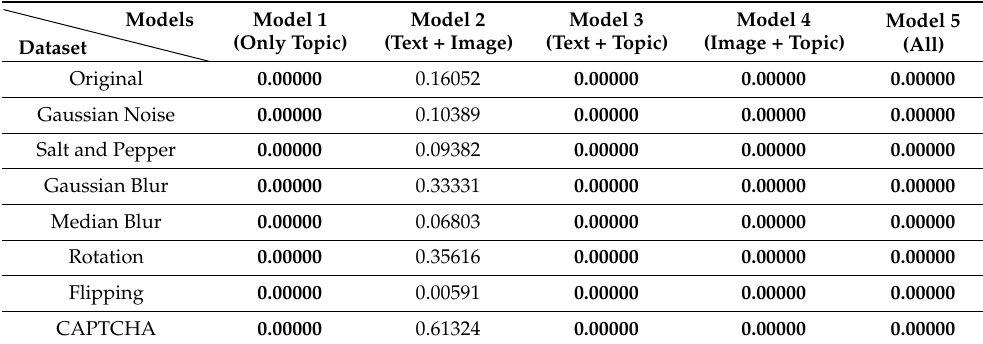
Table 17. p -value of chi-square test with Baseline 2 for the Dredze